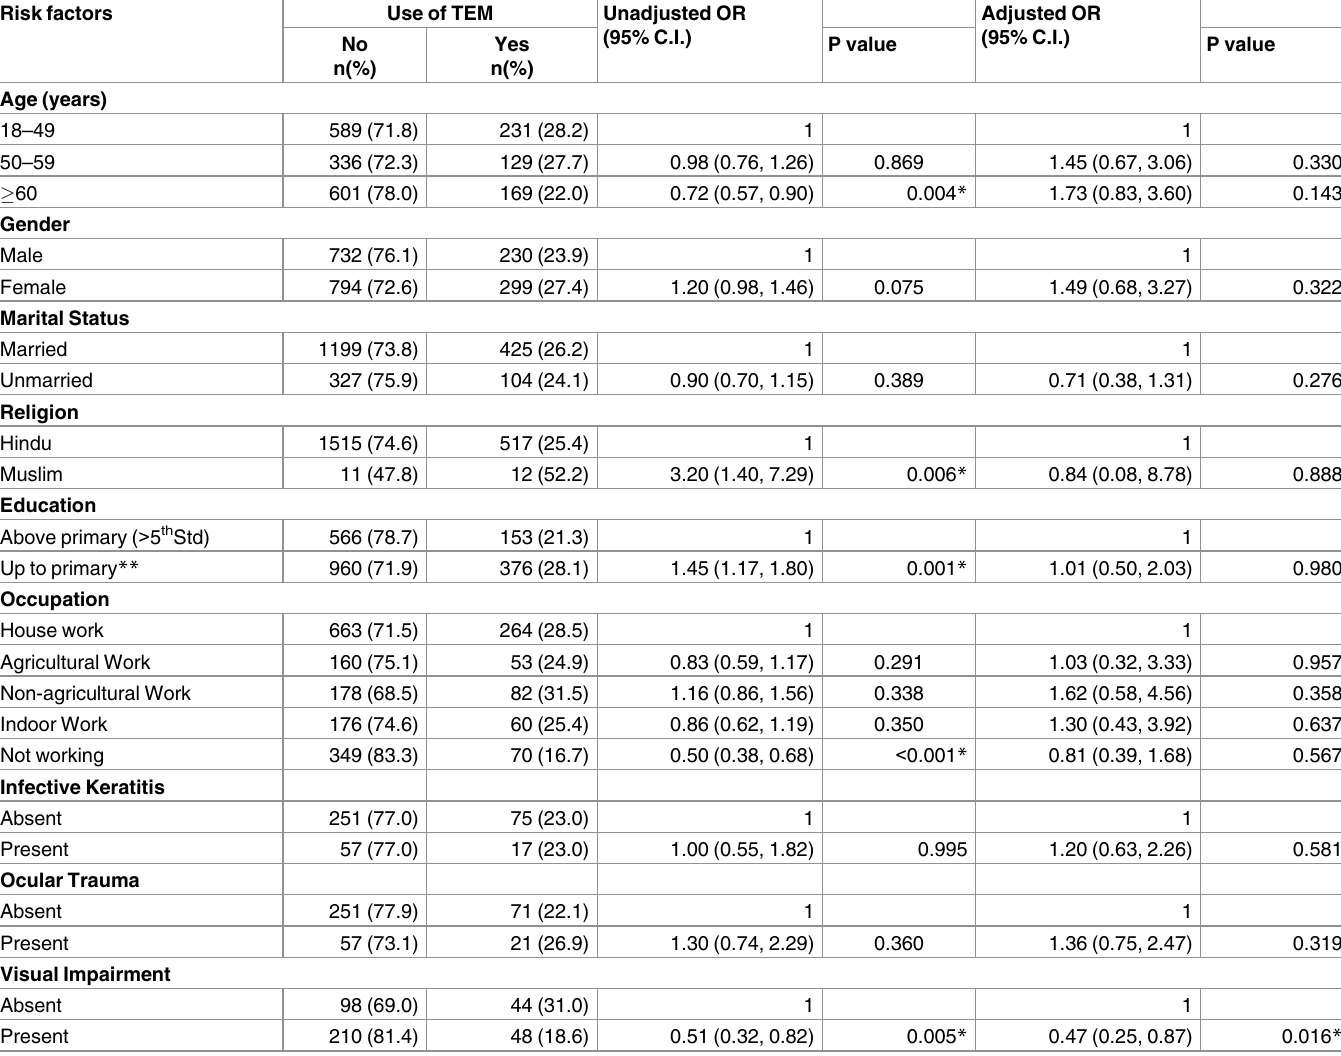
Table 2. Association of socio-demographic and clinical factors with use of traditional eye medicines (TEM) in the study